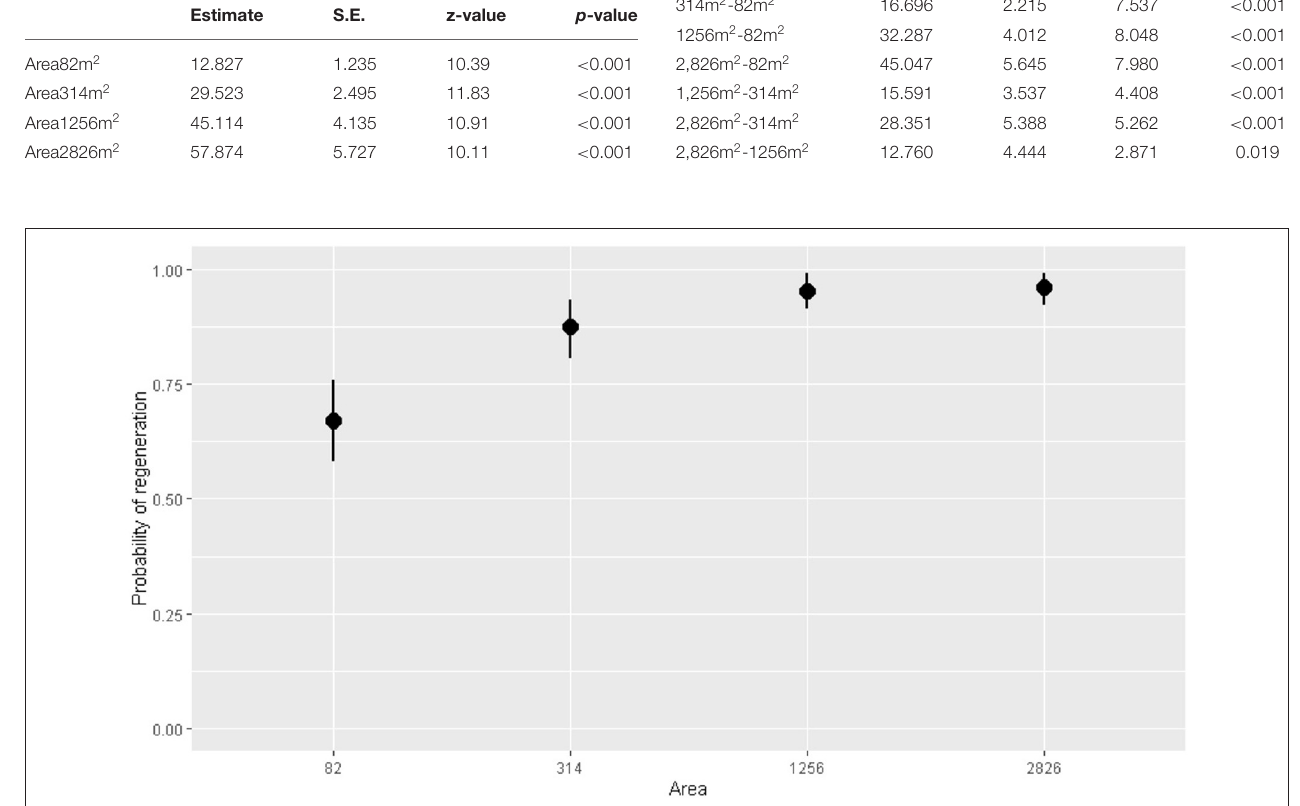
TABLE 1 | Generalized mixed-effects model results for the proportion of plots with conifer regeneration as plot area (m 2 ) increases. Estimate S.E.